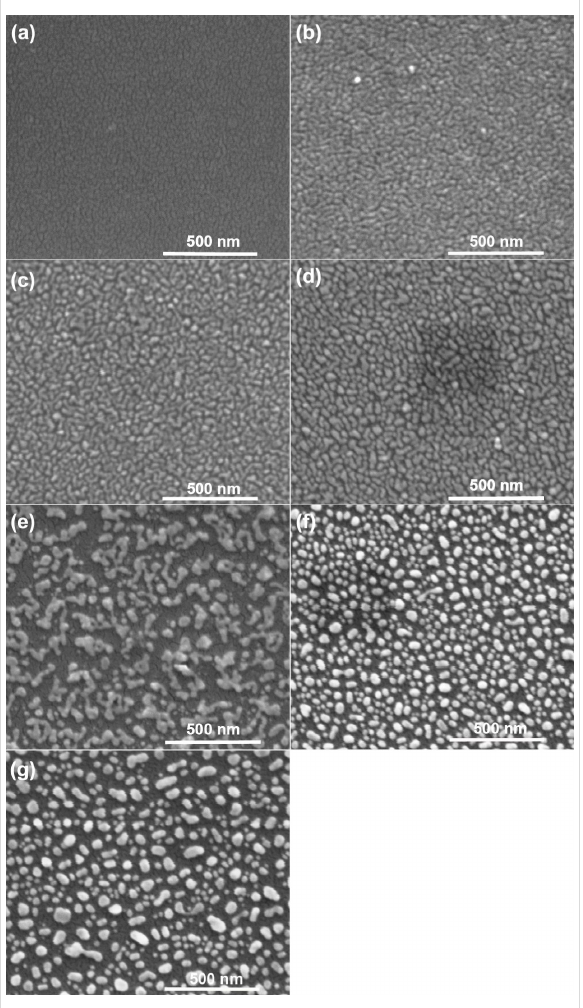
Figure 2: SEM images of 2.8 nm Au films on a Si(111) substrate: a) as prepared, annealed at b) 150 °C, c) 200 °C, d) 250 °C, e) 300 °C, f) 350 °C, g) 363 °C for 15